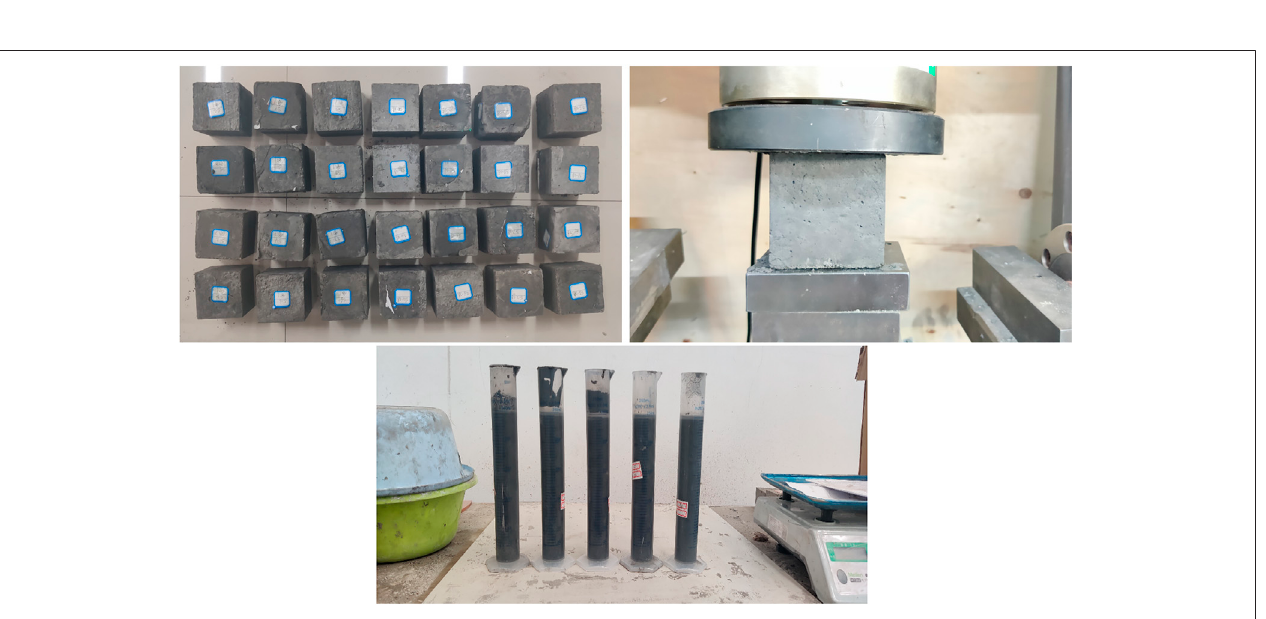
FIGURE 3 | Test pieces and test process of some